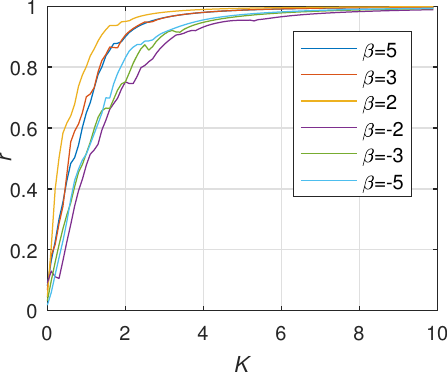
Figure 15. The stability of the weighted undirected network when β is ± 2, ± 3, ± 5.